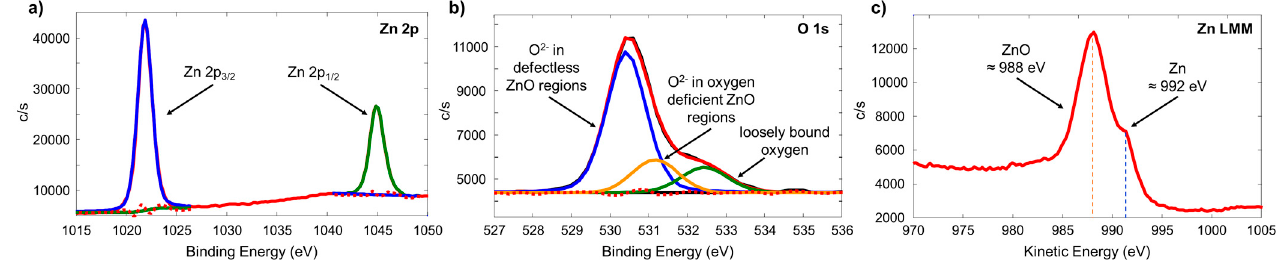
Figure 4. High-resolution XPS spectra of ZnO photocatalyst layer: ( a ) Zn 2p, ( b ) Zn LMM, and ( c ) O 1s.